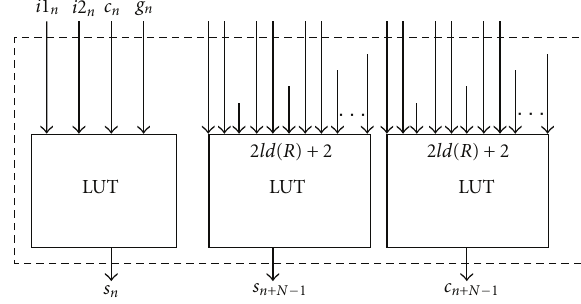
Figure 4: Optimized elementary cell for five-to-six-input LUT.